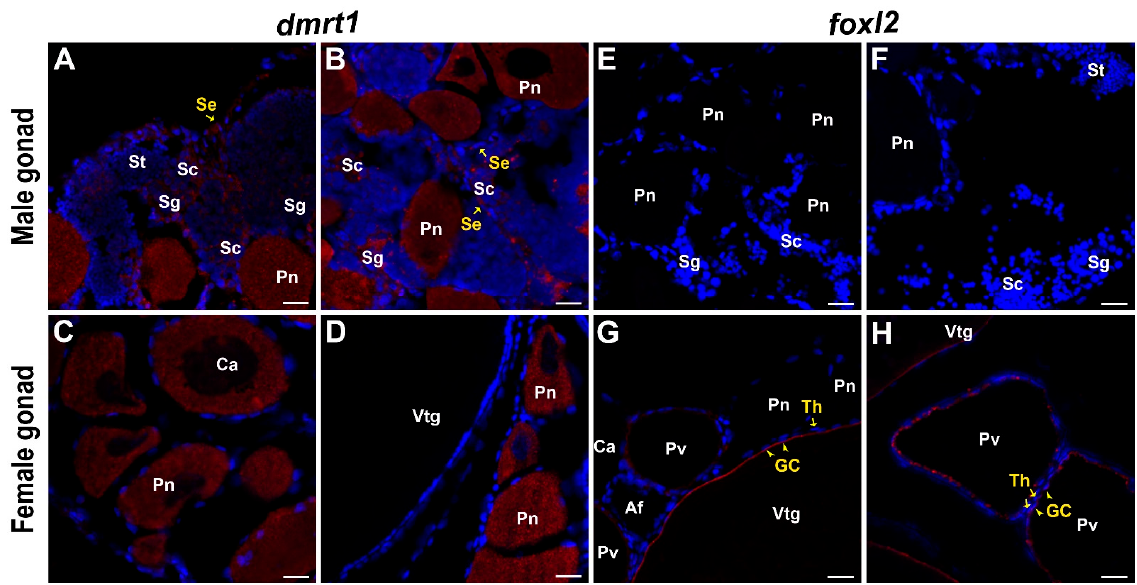
Figure 6. Expression patterns of dmrt1 and foxl2 in male and female gonads of A. clarkii . ( A , B ) The dmrt1 gene in the male gonad. ( C , D ) The dmrt1 gene in the female gonad. ( E , F ) The foxl2 gene in the male gonad. ( G , H ) The foxl2 gene in the female gonad. Red signal indicates the expression localization of target genes; blue signal indicates cell nucleus; Ca, Cortical Alveoli stage oocytes; Pn, Perinucleolus stage oocytes; Sc, Spermatocytes; Se, Sertoli cells; Sg, Spermatogonia; St, Spermatides; Vtg, Vitellogenic oocytes; Pv, previtellogenic oocytes; Af, atretic follicle; GC, granulosa cells; Th, theca cells; Scale bars = 20 µ